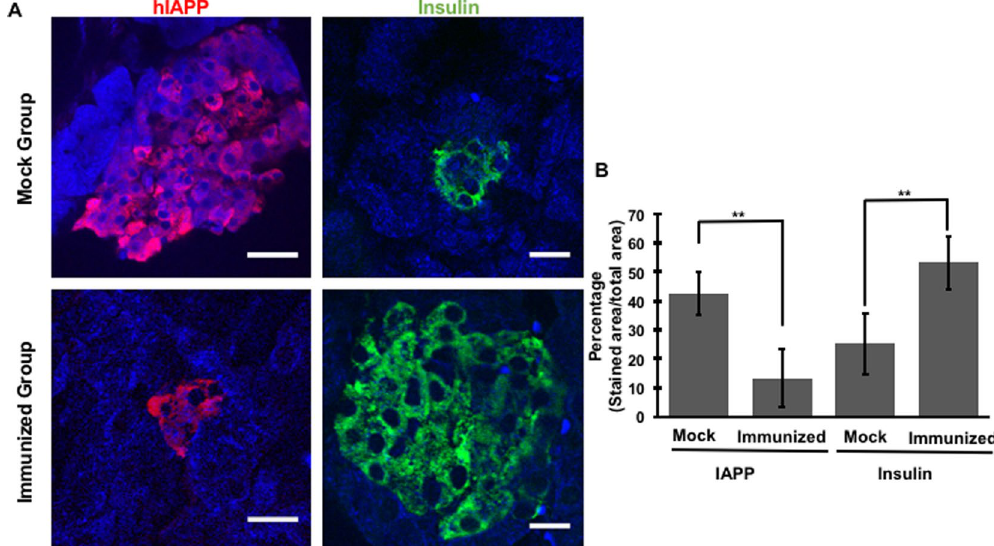
Figure 3. Treated mice had higher insulin content and less hIAPP accumulation in the pancreas. (A) Confocal microscopy analysis of histological sections of treated mice compared with the mock group. Histological sections were stained for hIAPP (red) and insulin (green). As shown, the treated group showed higher insulin levels and lower levels of hIAPP accumulation. Scale bar 200 µ m. ( B ) Quantification of insulin and hIAPP in immunized and mock groups (N = 4 per group), ** P <